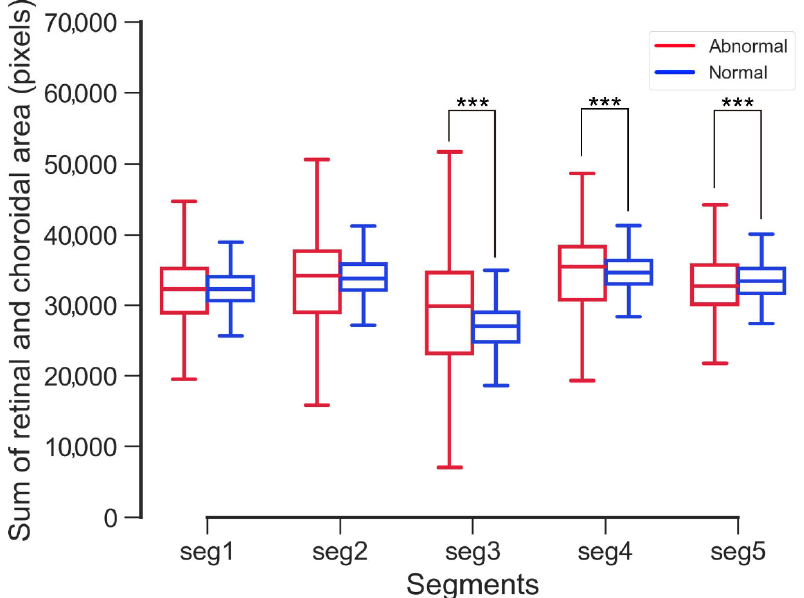
Figure 7. Sum of the retinal and choroidal areas in each segment. The peripheral temporal retina, temporal perimacular area, central macular area, nasal perimacular area, and peripheral nasal retina were defined as segments 1, 2, 3, 4, and 5, respectively. The sum of the retinal and choroidal areas was significantly thicker in abnormal eyes than in normal eyes in segments 3 and 4. Furthermore, the retinal and choroidal areas were significantly thinner in abnormal eyes than in normal eyes in segment 5. Abbreviation: seg, segment. *** p < 0.001.